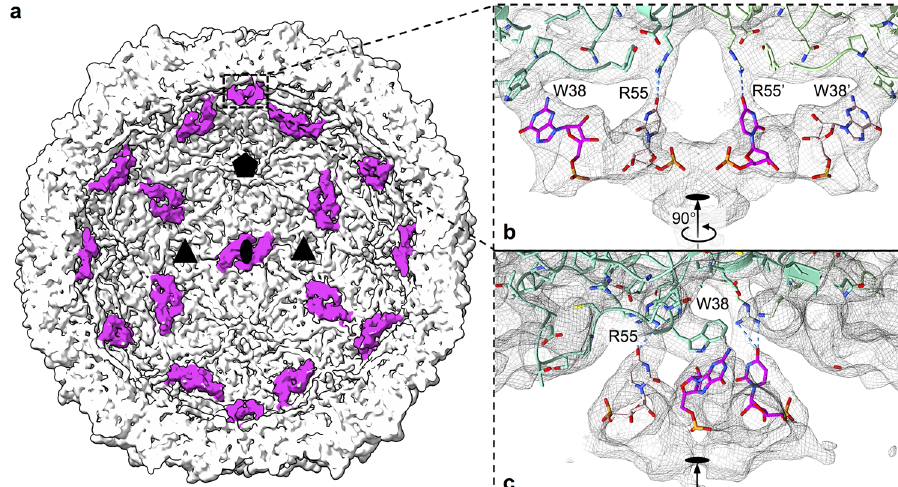
Fig. 5 Genome-capsid contacts in CV-A6 virion. a Surface representation of cryo-EM reconstruction of CV-A6 virion with front half removed to show putative icosahedrally ordered RNA segments (magenta) located next to twofold symmetry axes. Oval, triangle, and pentamer icons indicate two-, three-, and fi vefold icosahedral symmetry axes, respectively. b , c Mesh representation of density connecting putative RNA segments with side chains of Trp38 and Arg55 of VP2. The protein and RNA structures are shown in stick representation with carbon atoms of VP2 subunits distinguished by the hues of green. The carbon atoms of the two guanines and uracils modelled in the putative RNA density are shown in magenta and pink. Trp38 of VP2 is involved in a π – π stacking interaction with the guanine base. Arg55 of VP2 may form hydrogen bonds with uracil. The nucleotides are linked in a hexanucleotide and were re fi ned against the shown density map using the software ChimeraX plugin ISOLDE 98 . c View perpendicular to b . For clarity, only the Trp38:guanine stacking interaction in front of the twofold axis is